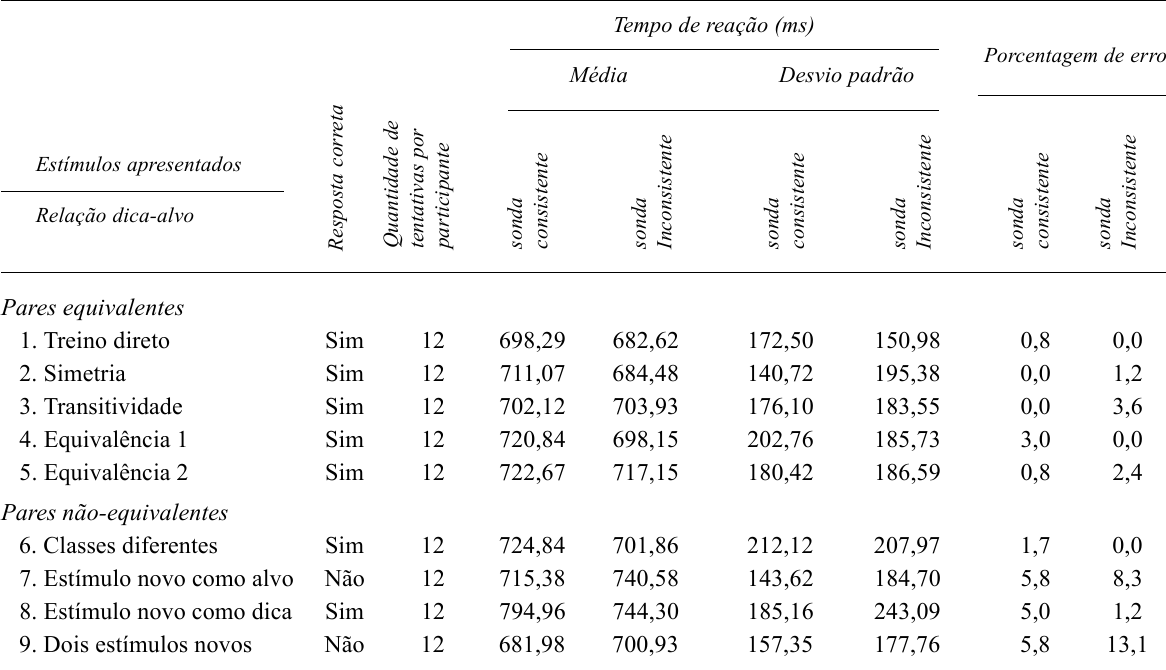
Os Nove Tipos de Tentativas e Estatísticas Descritivas Relacionadas a eles para os Participantes que Passaram